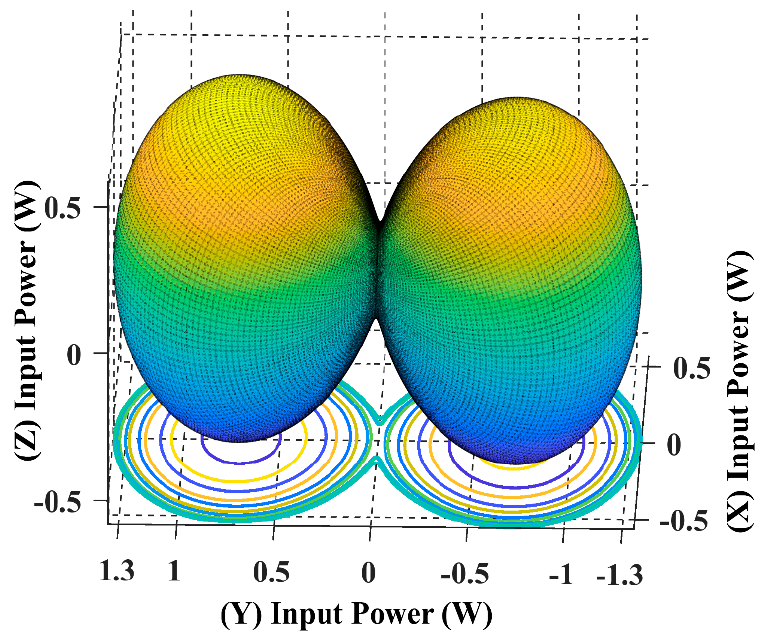
Figure 13. The input power spherical plot for the 3D WPT system when the receiver is placed at α = φ = 90°.